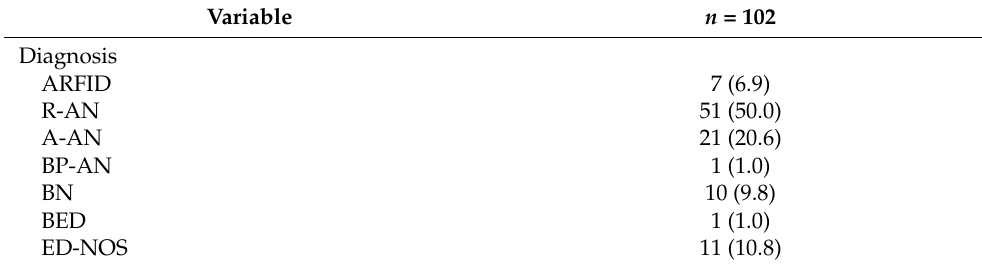
Table 1. Cont. Variable n = 102 Diagnosis ARFID 7 (6.9) R-AN 51 (50.0) A-AN BP-AN